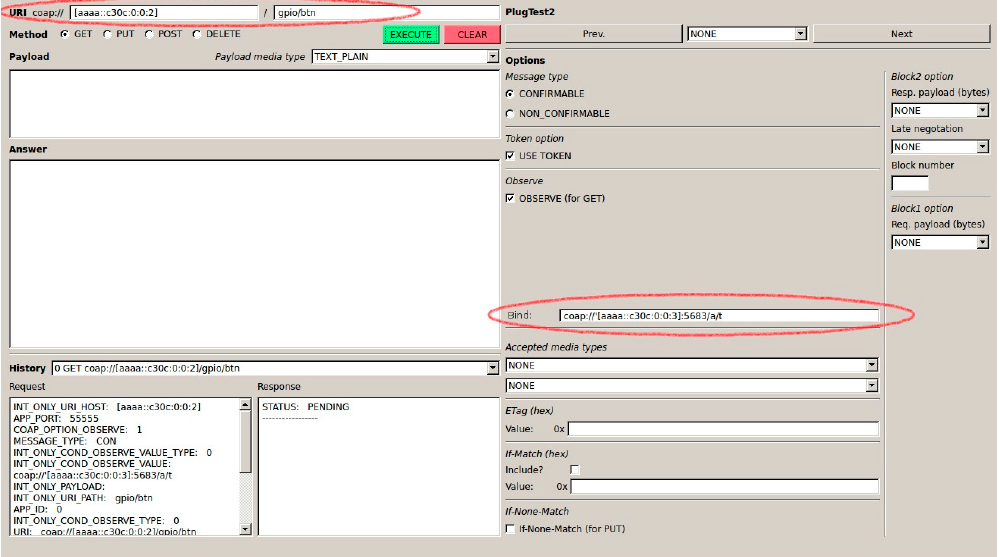
Figure 12. Creation of Binding Using CoAP++ GUI from Non-constrained Device.